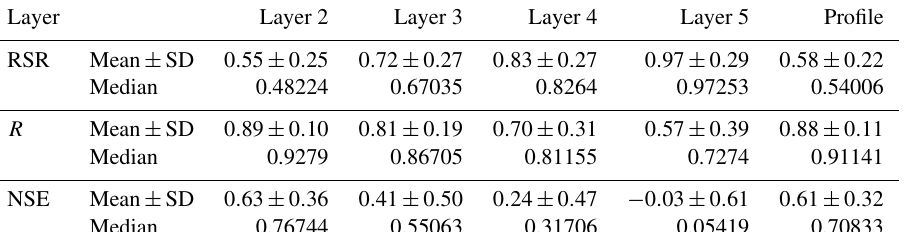
Table 3. The statistics (mean ± standard deviation and median) of the performance (RSR, R , and NSE) of the ExpF method for estimating the subsurface SM using the surface SM for each layer of 35 observation stations during the growing seasons of 2014, 2015, and 2016.